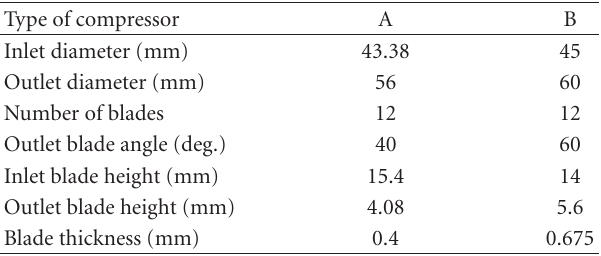
Table 1: Specifications of